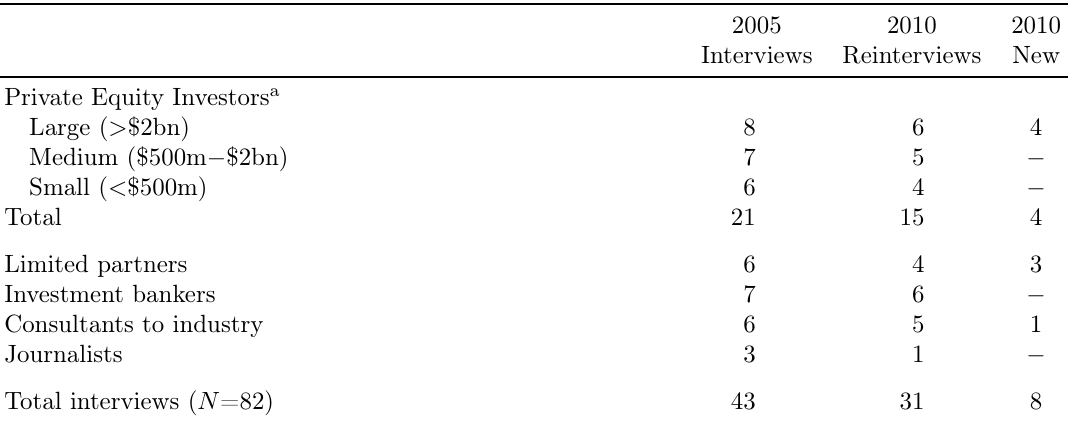
Table 1: Qualitative